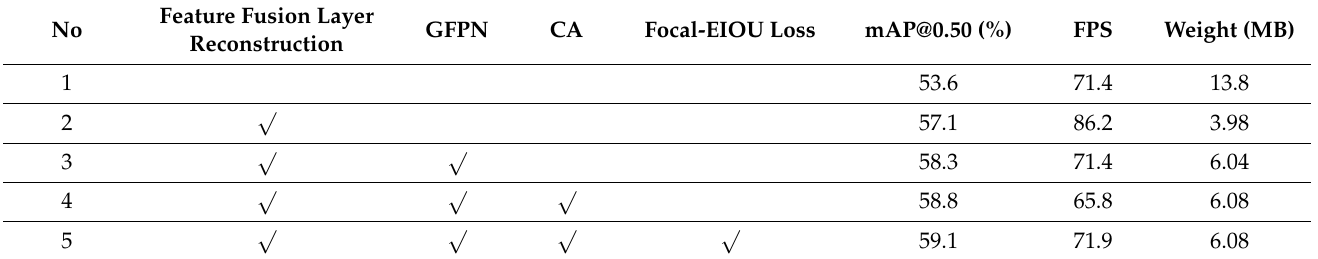
Table 4. Comparison of ablation experiment results.